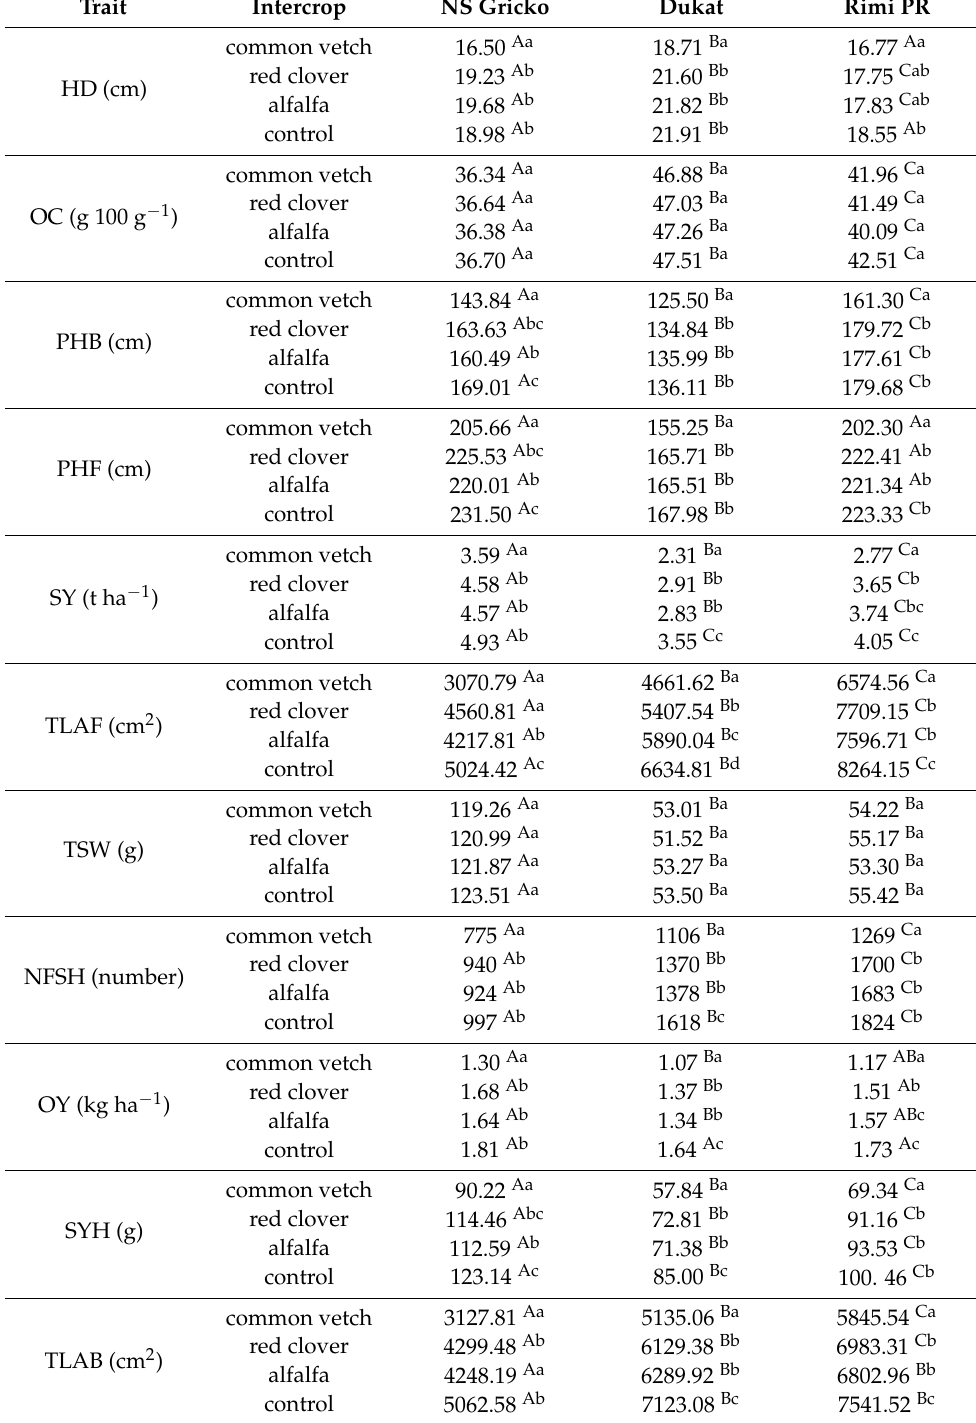
Table 4. Least-square means difference for sunflower traits analyzed by the selected model in sunflower legume